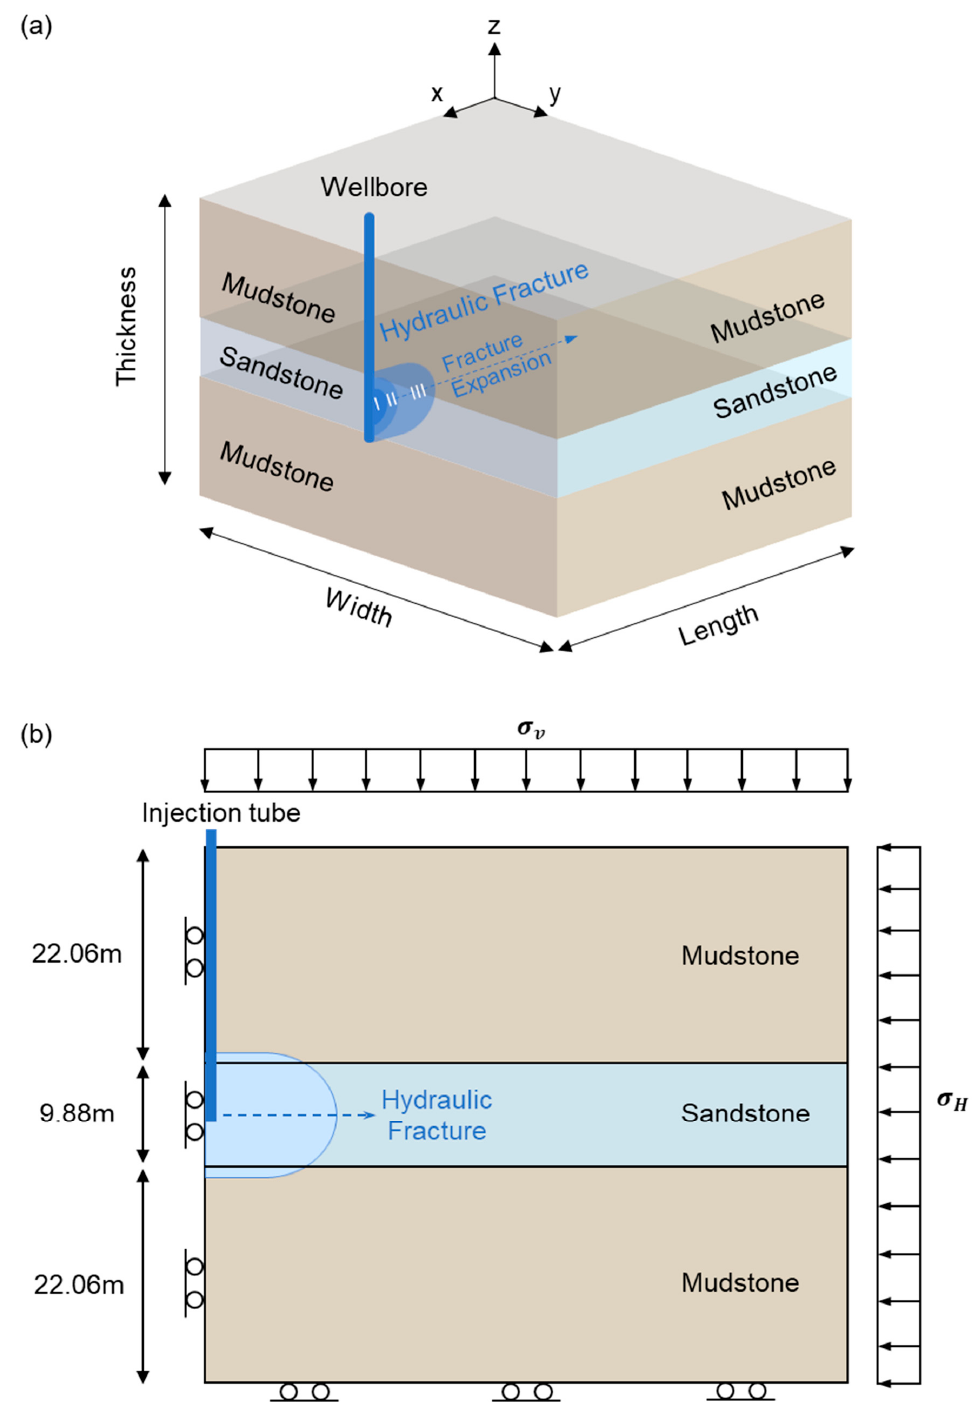
Figure 3. Hydraulic fracturing calculation model. ( a ) A 3D geological structure and ( b ) representation of the calculation model with applied boundary conditions. Fracturing is carried out in the reservoir, and with the increase of fracturing time, hydraulic fracture gradually extends to the barrier.